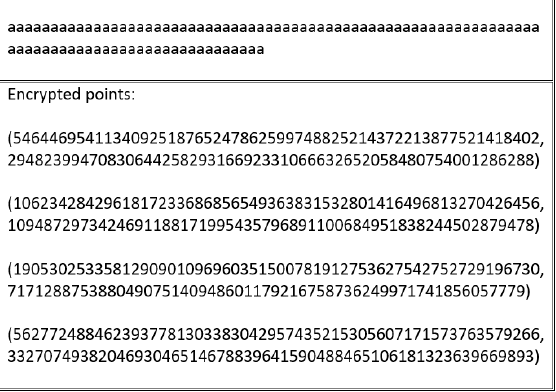
Figure 21. Improved encryption process generating different encrypted points even with the same